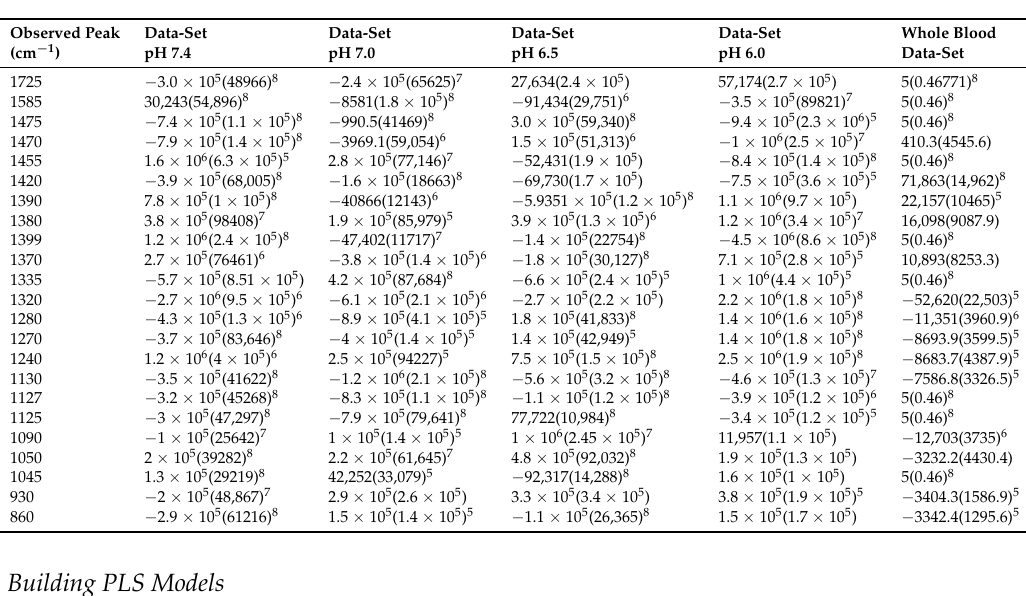
Table 1. Linear Regression (1) on observed peaks (cm − 1 ) pertinent to lactate ion or lactate containing compounds in solution. (Coefficient and Standard errors in parenthesis. p -values depict